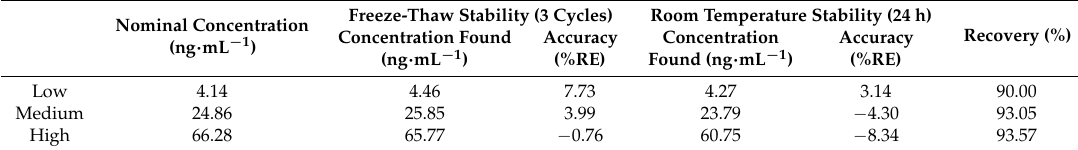
Table 3. Stability and recovery testing of serotonin in QC samples (low, medium,